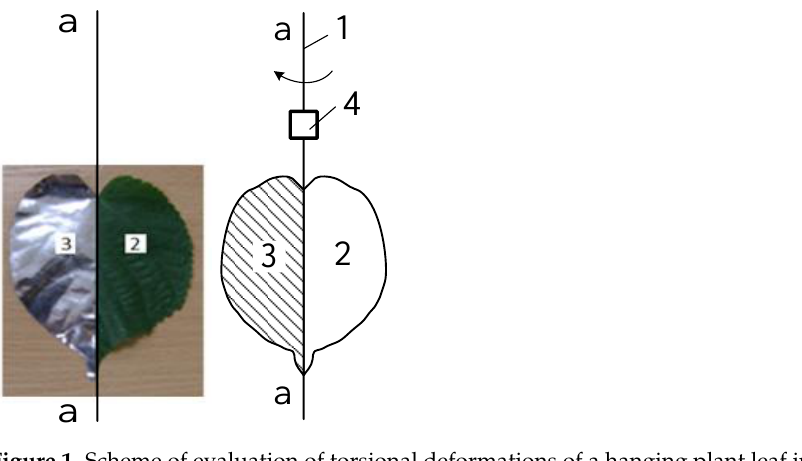
Figure 1. Scheme of evaluation of torsional deformations of a hanging plant leaf in a galvanometer thread: cross-section a – a — leaf suspension (rotation) axis; 1 — a metal filament from a galvanometer; 2 — active leaf blade surface area; 3 — surface area of a leaf blade covered with heat reflecting coating; 4 — light wave reflection mirror to measure the rotation of the leaf.